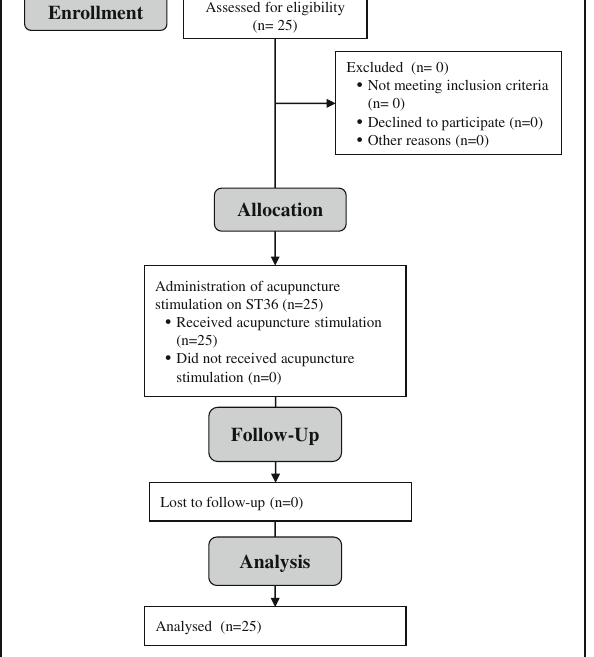
Table 2 Demographic characteristics of the